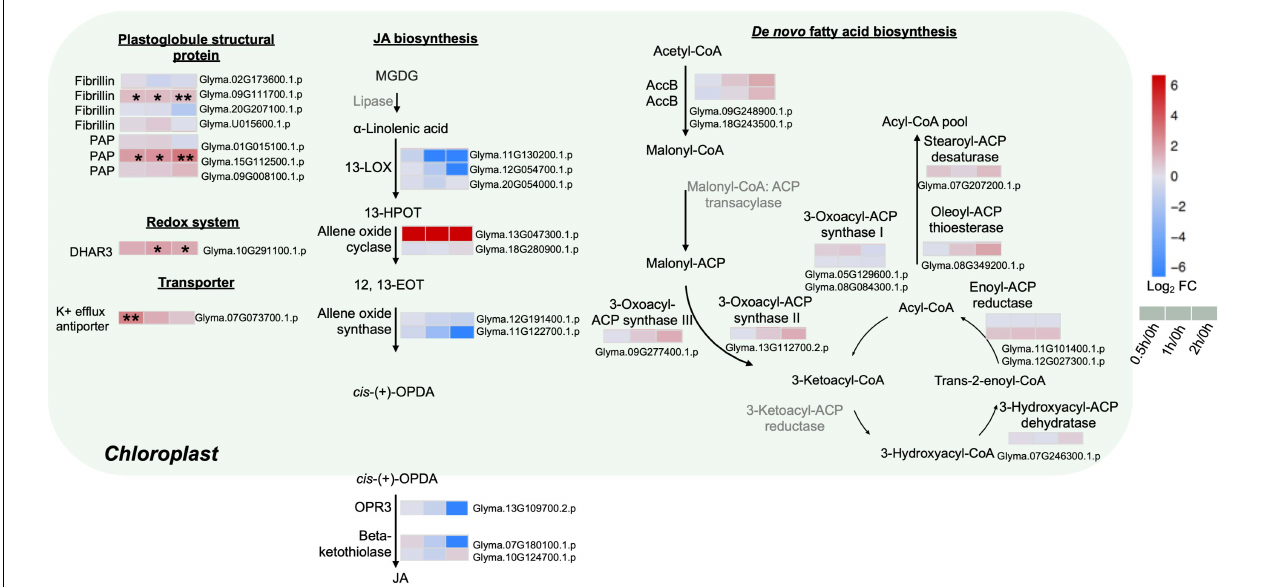
FIGURE 4 | Proteins with differential abundance related to various metabolic pathways in the chloroplasts and peroxisomes during salt stress in leaves of soybean ( Glycine max [L.] Merr.) accession C08. Each significant differentially expressed protein is presented as heatmaps with shades of red or blue according to the scale bar. Scale bar indicates log 2 -fold changes of protein abundance (stress vs. control) with an adjusted p -value ≤ 0.05. *, significant difference at p ≤ 0.05; **, significant difference at p ≤ 0.01 using ANOVA test. For tandem mass spectrometry, the total leaf protein was extracted from leaves of 14-day-old C08 seedlings grown in 1/2 strength Hoagland solution and treated with or without 0.9% (w/v) NaCl. Differential protein abundances were calculated by label-free quantification of MS peptide signals. AccB, biotin carboxyl carrier protein of acetyl-CoA carboxylase; ACP, acyl carrier protein; DHAR3, dehydroascorbate reductase 3; 12, 13-EOT, 12, 13-epoxyoctadeca-9, 11, 15-trienoic acid; 13-HPOT, 13 hydroperoxyoctadeca-9, 11, 15-trienoic acid; JA, jasmonic acid; 13-LOX, 13-lipoxygenases; OPR3, 12-oxophytodienoate reductase 3; PAP, plastid lipid-associated